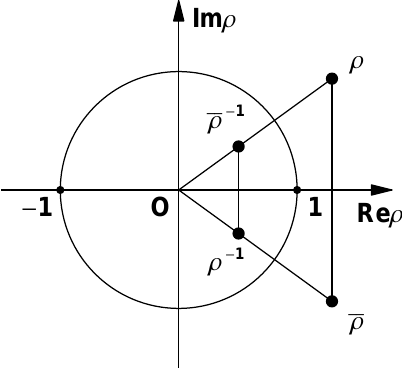
Figure 1. Position of the characteristic multipliers in the complex